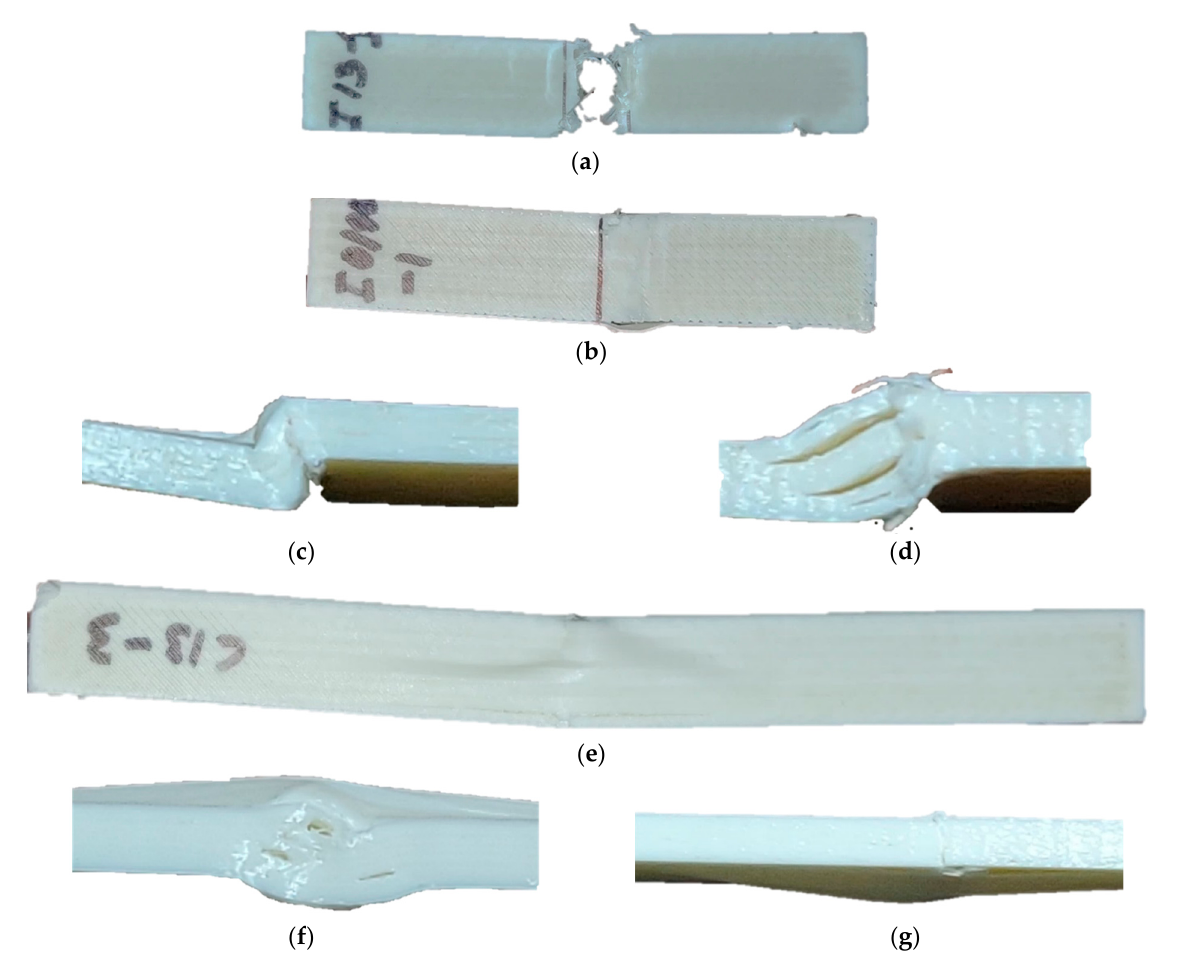
Figure 8. Fractography of pendulum-impacted samples: ( a ) Hinge break of a 0/45/90/ − 45 specimen; ( b – d ) non-break of a Izod 0/0 specimen’s top and side views, and ( e – g ) non-break of a Charpy 0/45/90/ − 45 specimen’s top and side views.